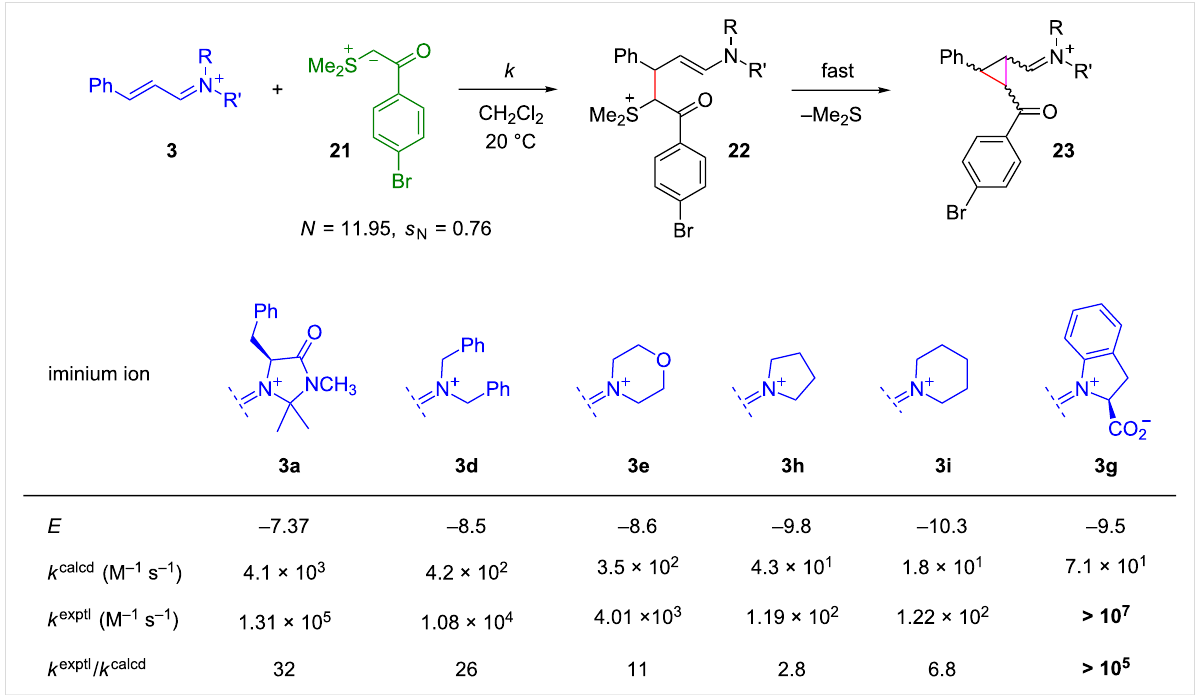
Figure 14: Comparison between experimental and calculated (Equation 1) cyclopropanation rate constants [64].